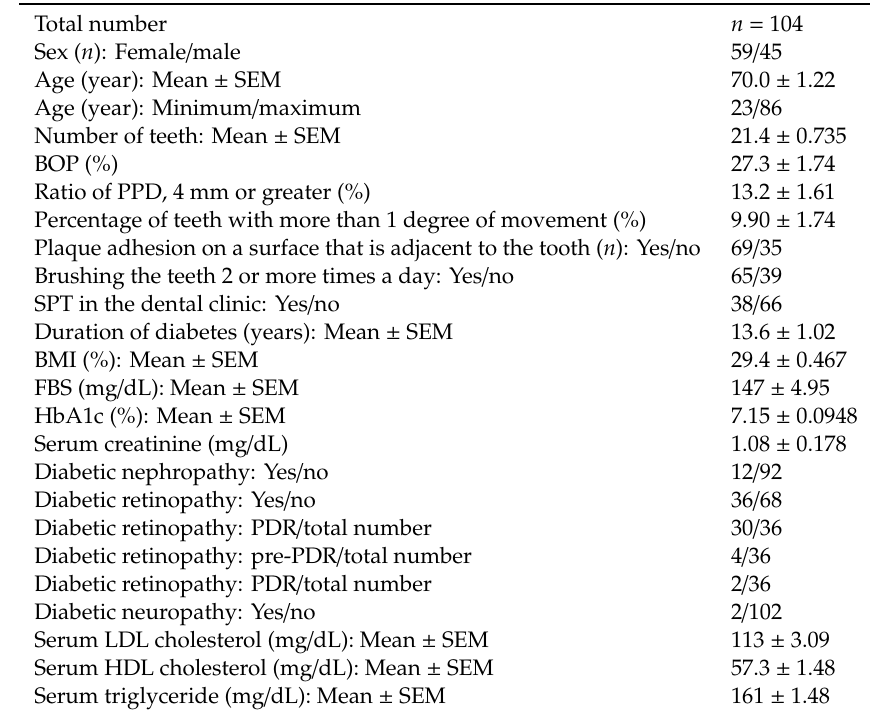
Table 1. Characteristics of the subjects in this